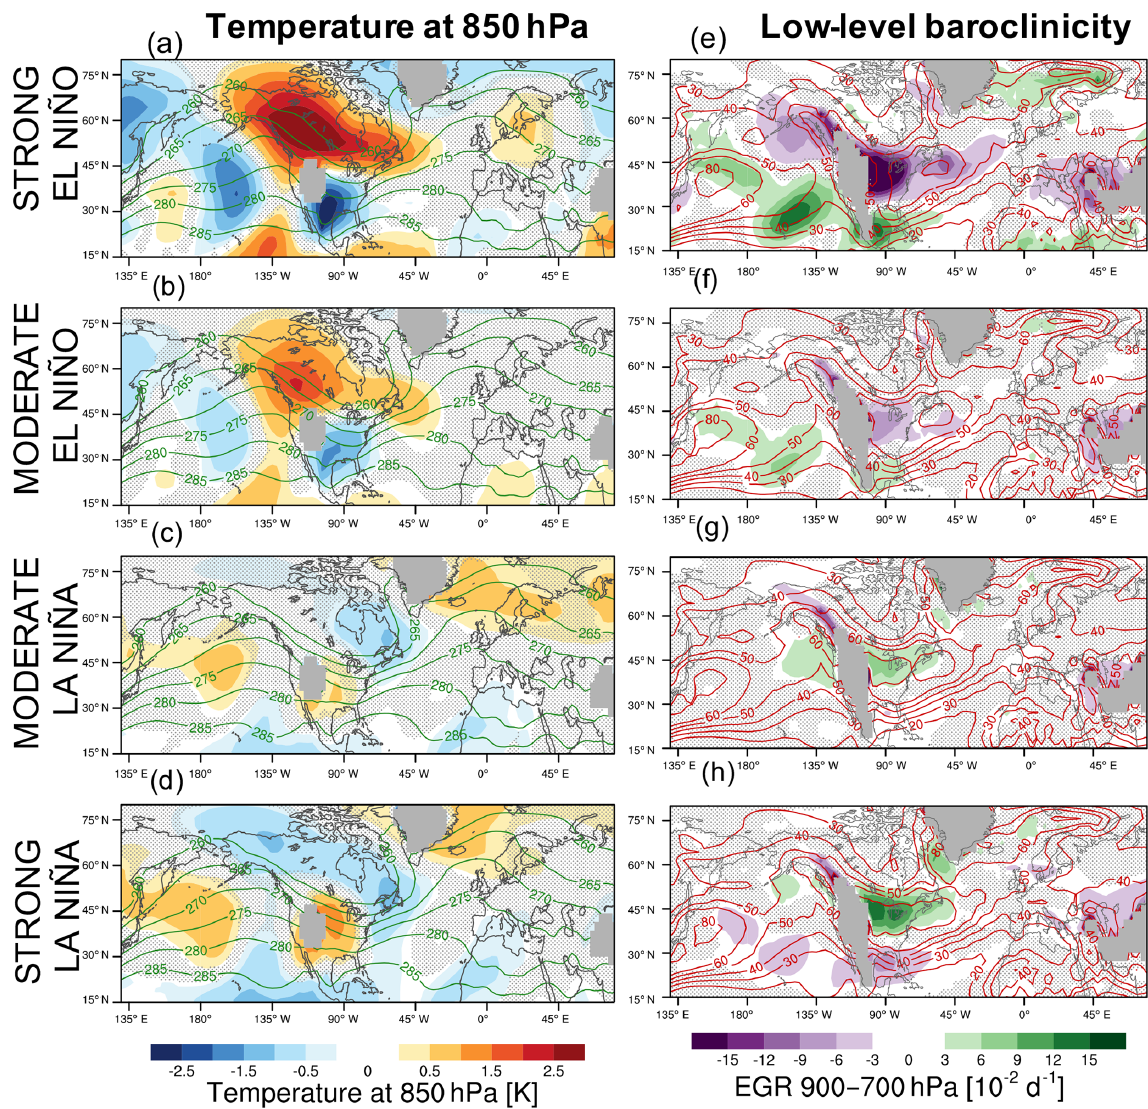
Figure 4. As in Fig. 2 but for (a–d) the temperature at 850hPa and (e–h) the Eady growth rate (EGR) vertically integrated between 900 and 700hPa. Contour lines indicate the absolute values of temperature (K) and EGR (10 − 2 d − 1 ). Non-statistically significant values below the 95% confidence level are dotted in